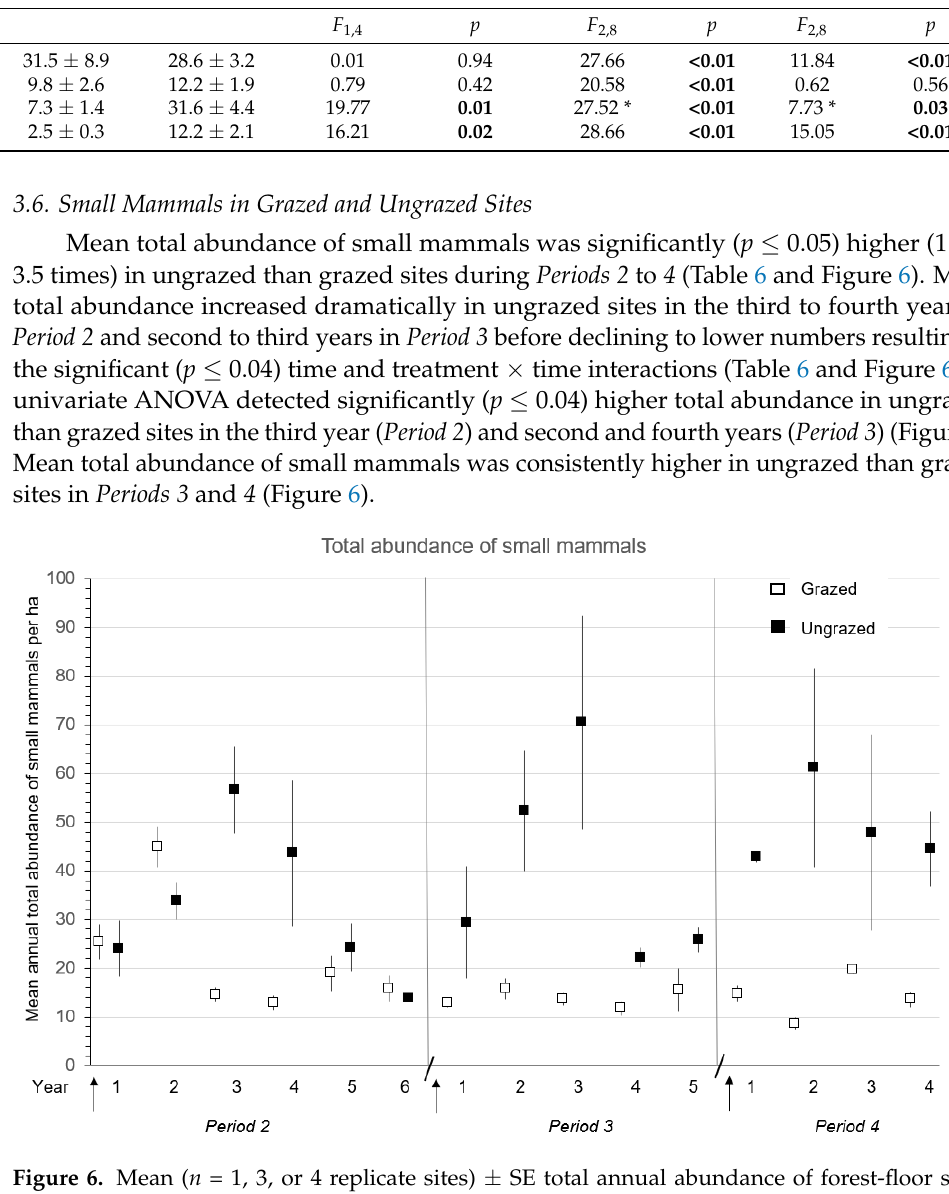
Figure 6. Mean ( n = 1, 3, or 4 replicate sites) ± SE total annual abundance of forest-floor small mammals in the first four to six complete years in grazed and ungrazed sites after clearcut harvesting during the three Periods : 2 (1997–2002 and 2004–2009), 3 (2007–2011 and 2012–2016), and 4 (2017–2020 and 2016–2019) for the CC-GR study in southern British Columbia, Canada. Arrow indicates time of harvesting on clearcut sites. Diagonal line separates Periods Table 6. Overall mean ( n = 3 × 6; 3 × 5; 3 or 4 × 4; sites × years) ± SE annual total abundance, species richness, and species diversity of forest-floor small mammals in grazed (Summerland) and un- grazed (Golden) clearcut sites for comparable years post-harvest for the CC-GR study in southern BC, Canada 1997 to 2020, and results of RM-ANOVA for Periods 2 , 3 , and 4 . Within a row, columns of mean values with different letters are significantly different. F -values identified by * were calcu- lated using an H-F correction factor, which decreased the stated degrees of freedom due to correla- tion among repeated measures. Significant values are given in bold text.